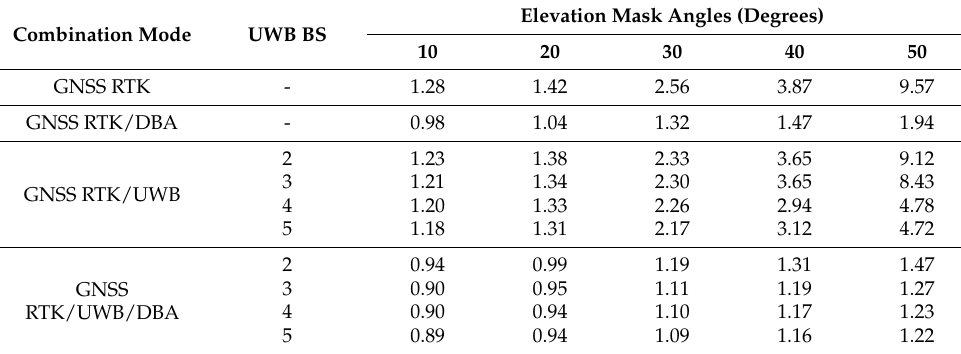
Table 2. Average PDOP values of the GNSS RTK/UWB/DBA fusion positioning model at various elevation mask angles in a static